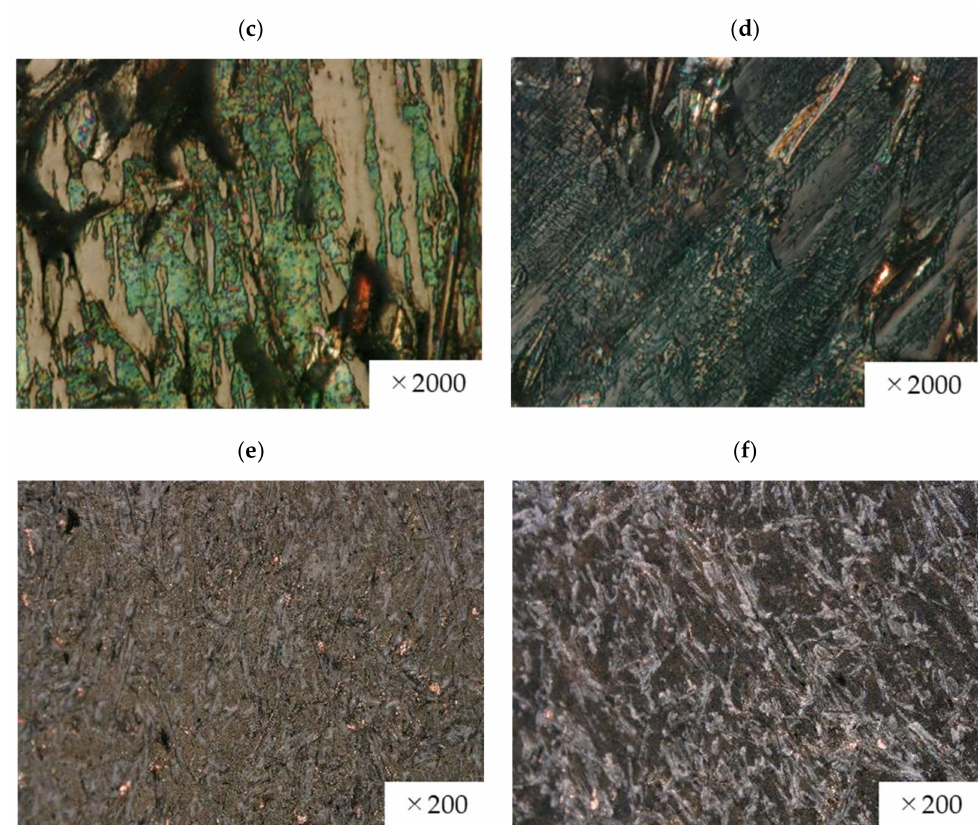
Figure 3. Images of the surface of plating film peeled off A504X90B ( a – d ) and Prototype A ( e , f ) test pieces that had been ultraviolet-pretreated under ( a , c , e ) dry (7.5 g/m 3 ) and ( b , d , f ) wet conditions (18.2 g/m 3 ): high ( c , d ) and low ( a , b , e , f ) magnification.